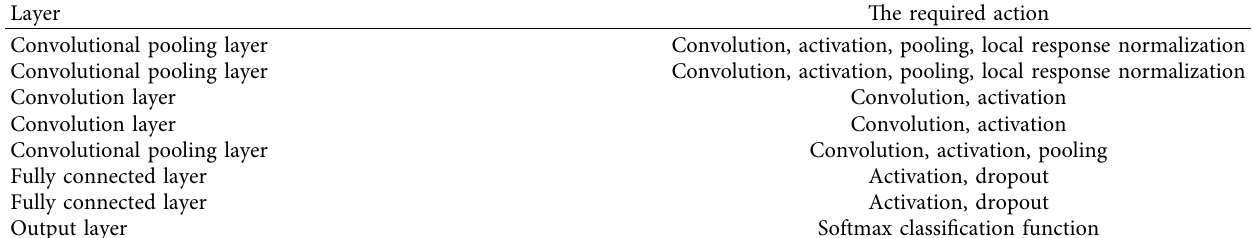
Table 1: Model structure.